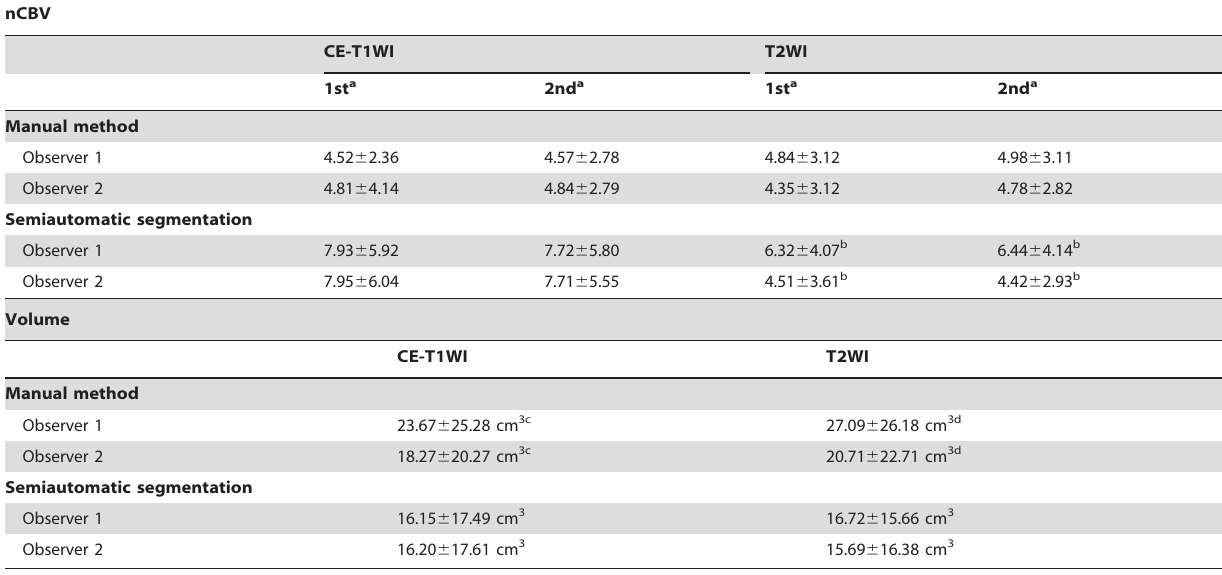
Table 1. nCBV values and